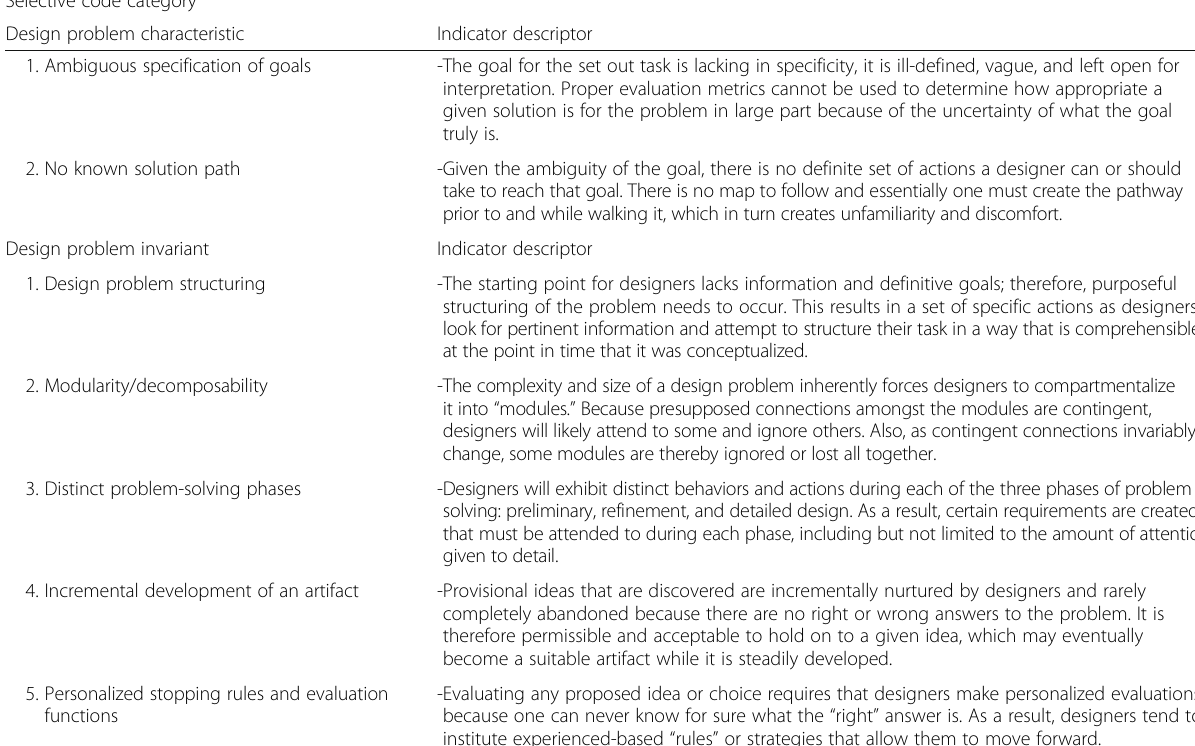
Table 4 Selective coding schema for characteristics and invariants of a design problem Selective code